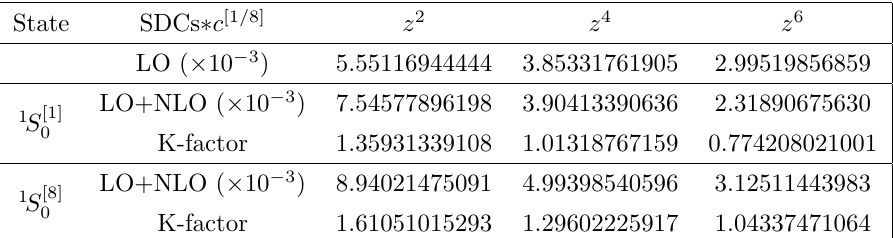
) + X at LO and NLO. The dotted 0 (cid:0) (cid:1) d [1] ( z ) + d [1] ( z ) (cid:2) (6 m 3 ), with scale choices b LO NLO